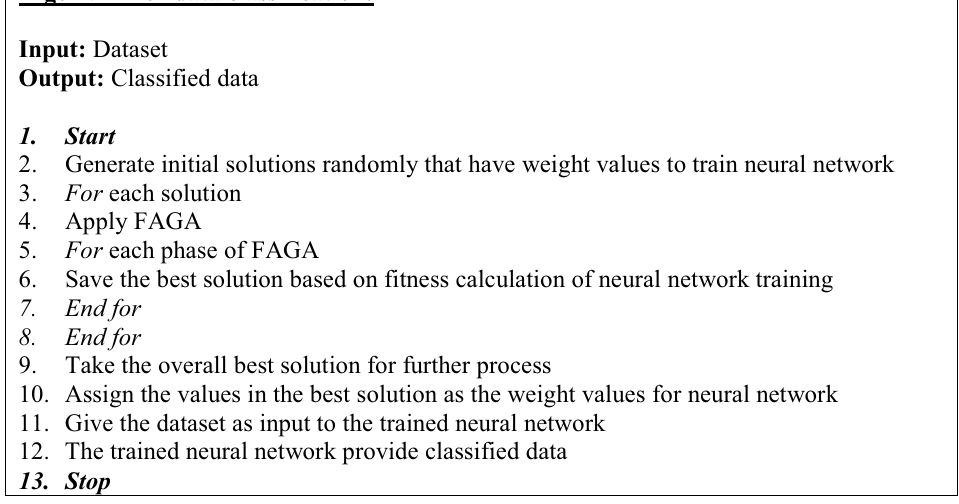
Fig.7. Algorithm for the application of FAGA on Data